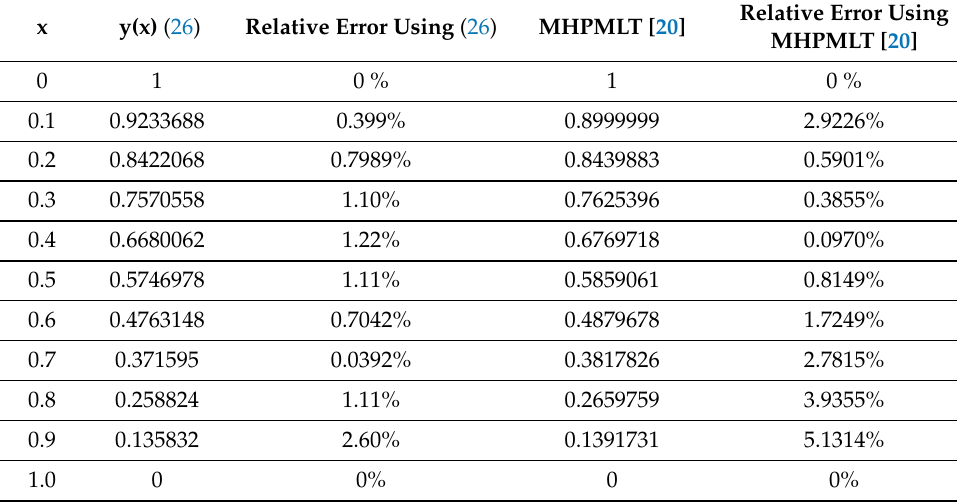
Table 1. Relative errors for (26) and MHPMLT